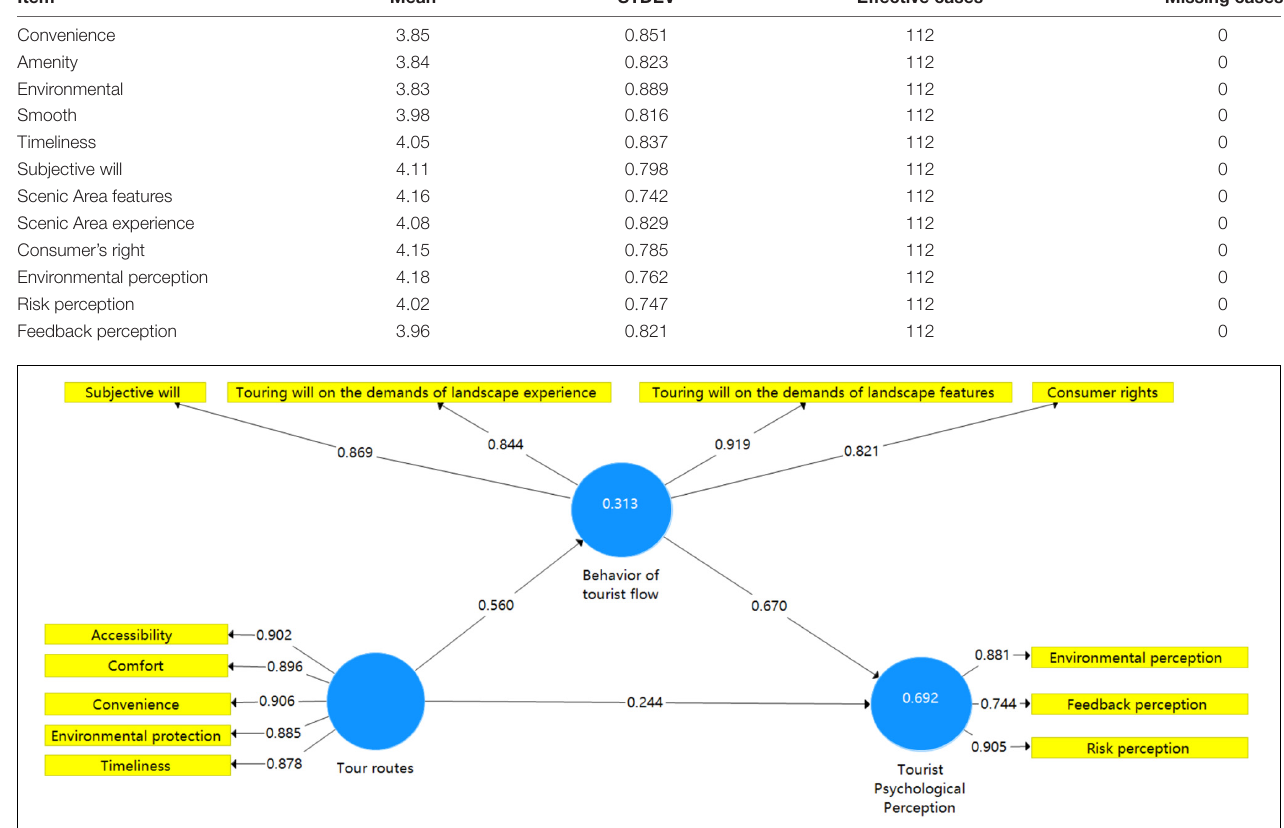
FIGURE 2 | Reflective measurement